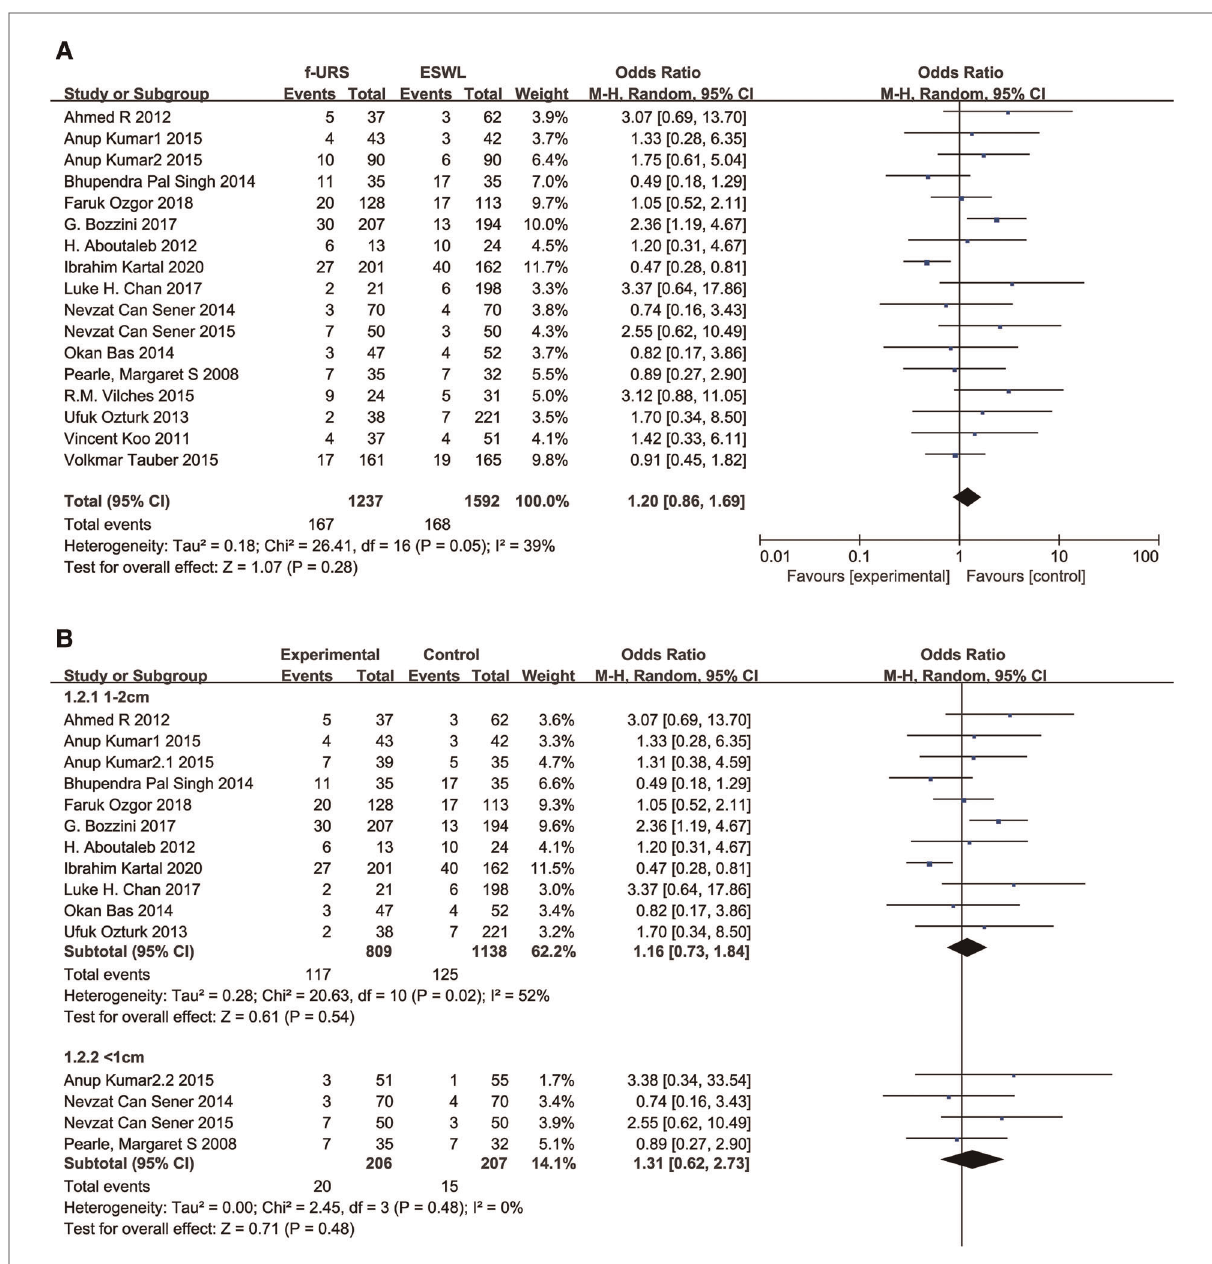
FIGURE 5 Forest plot and meta-analysis of complications rate for ( A ) all studies and ( B ) subgroups of stone length 1 – 2 cm and <1 cm for f-URS and